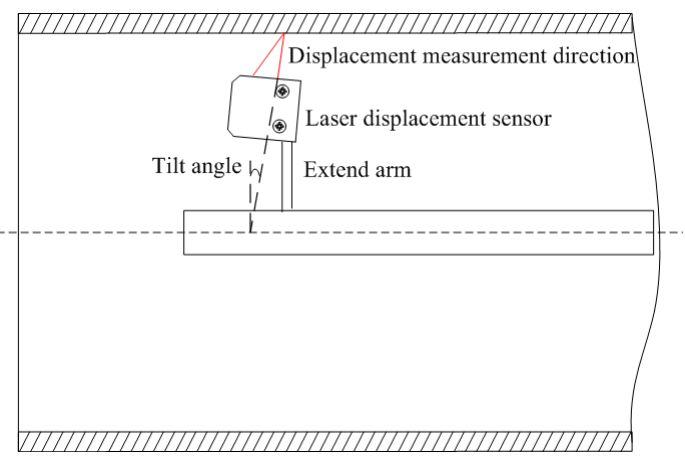
Figure 2. Tilt and offset systematic